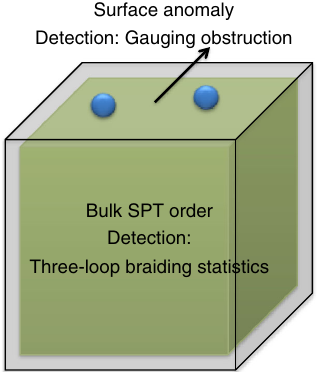
FIG. 1. In this paper, we study 2D anomalous SETs as surface state of nontrivial 3D SPT phase. On the one hand, we detect anomaly in surface SET from gauging obstruction; on the other hand, we construct the bulk model and detect the nontrivial SPT order with three-loop braiding